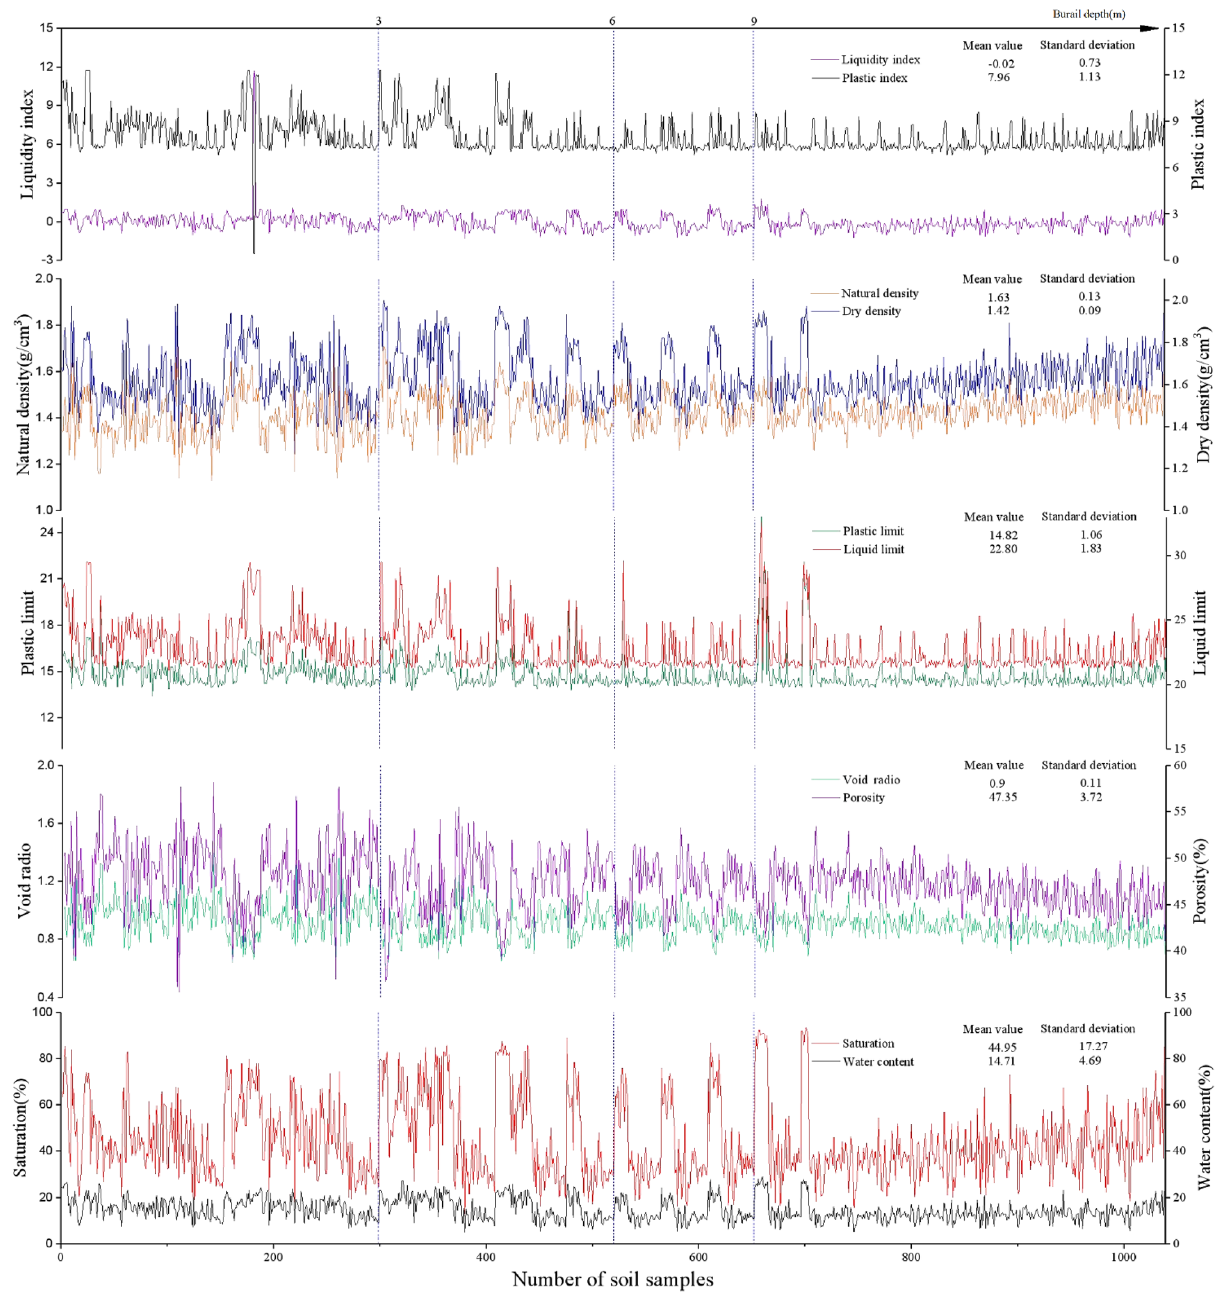
Figure 2. Physical parameters of soil